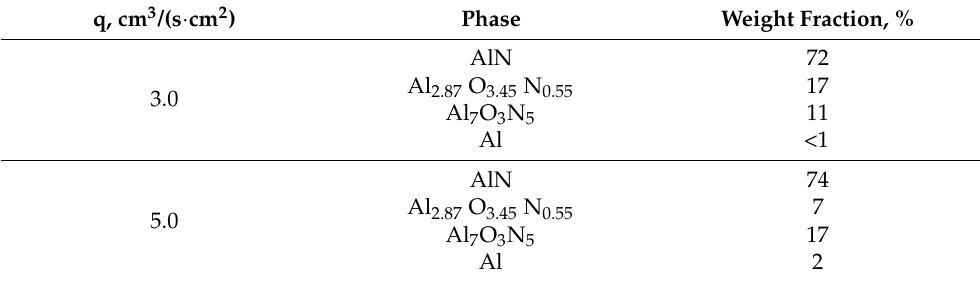
Table 6. Weight fraction of phases in the combustion products (the nitrogen–argon